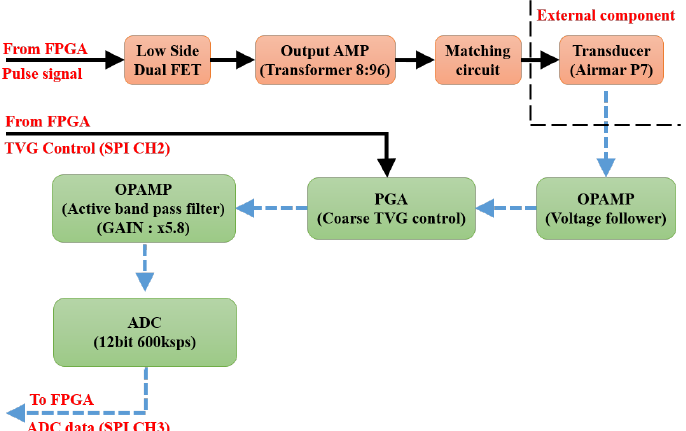
Figure 6. Analog circuit block diagram of